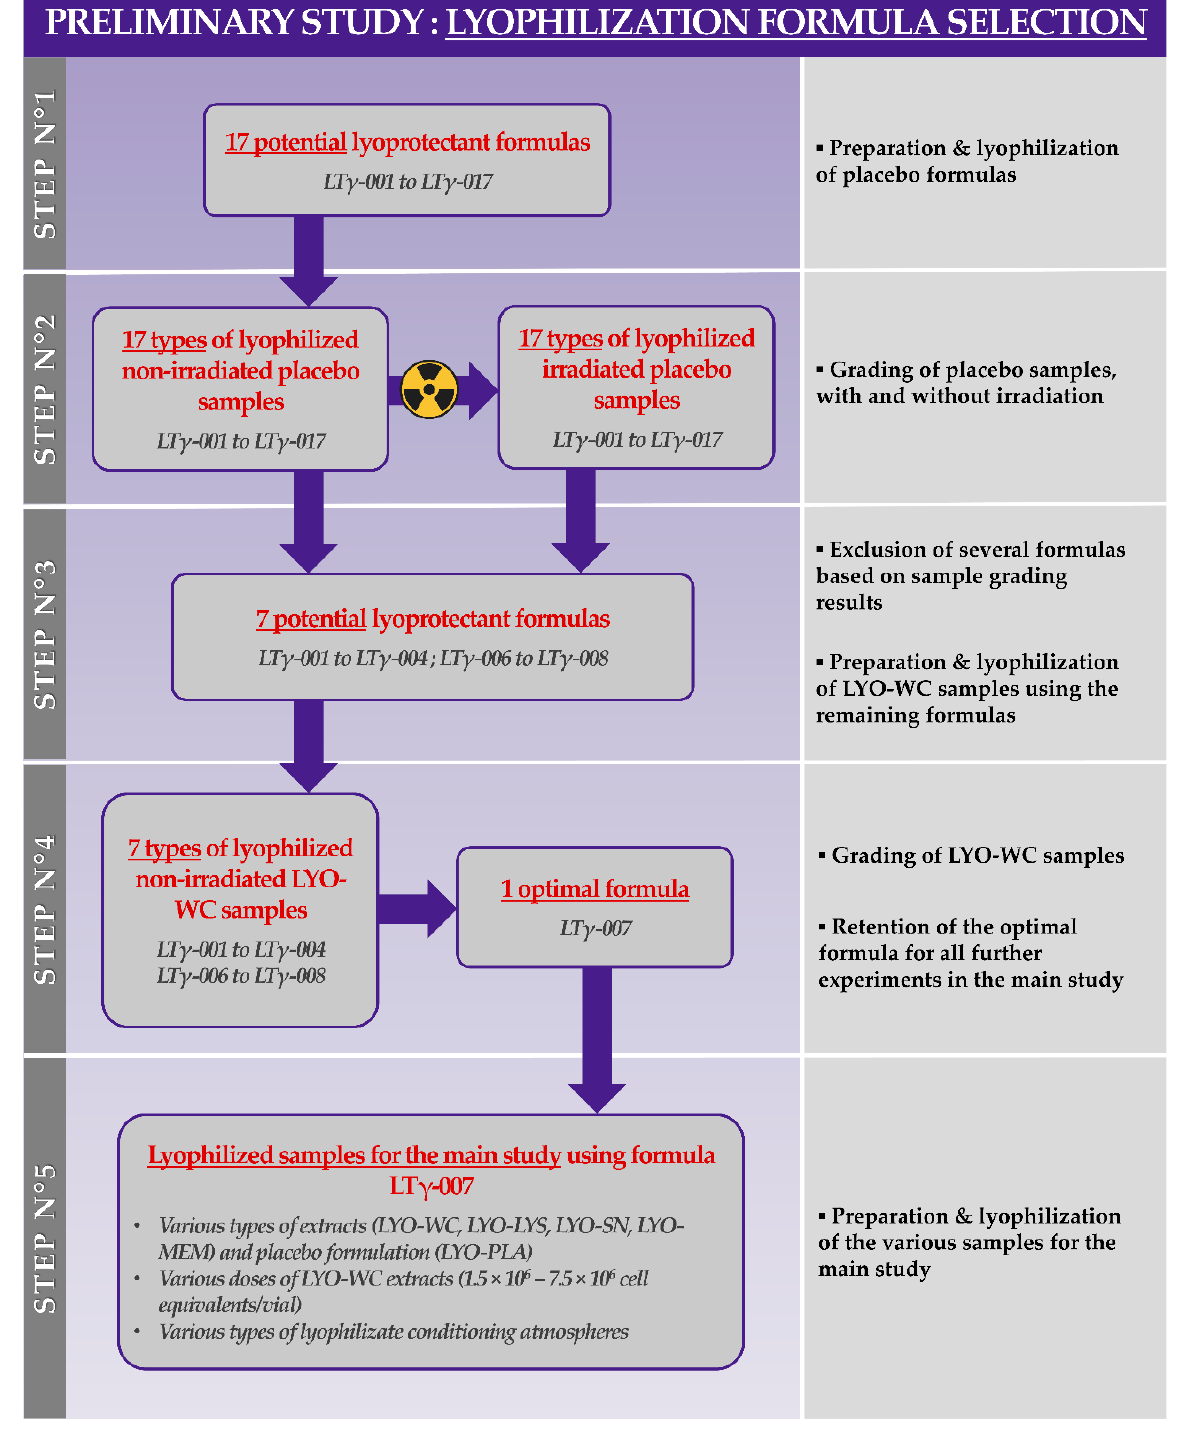
Figure A2. Schematic workflow of the preliminary formulation study, which enabled the selection of the optimal lyoprotectant formula for all of the assays of the main study. Placebo samples contained no cellular derivatives. LYO-PLA, lyophilized placebo sample; LYO-LYS, lyophilized lysate fraction; LYO-MEM, lyophilized membrane fraction; LYO-SN, lyophilized soluble fraction; LYO-WC, lyophilized whole-cell fraction.